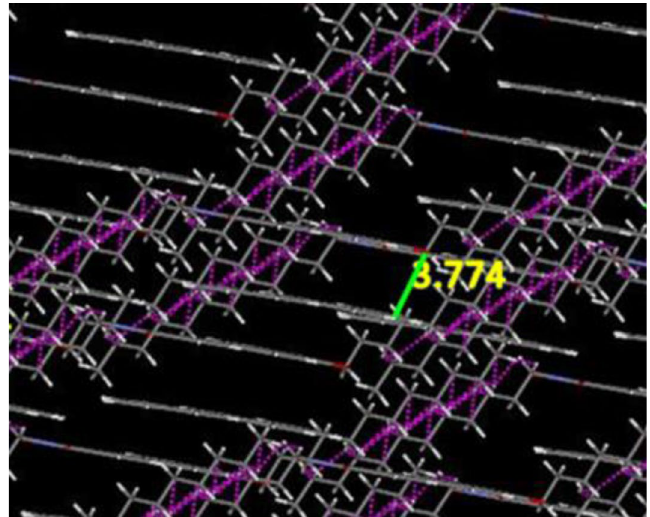
Figure 7. The stacking patterns of 1:1 D/A blends at MedeA VASP version 1.0 using VASP 5.3.3 (https ://www. vasp.at/).